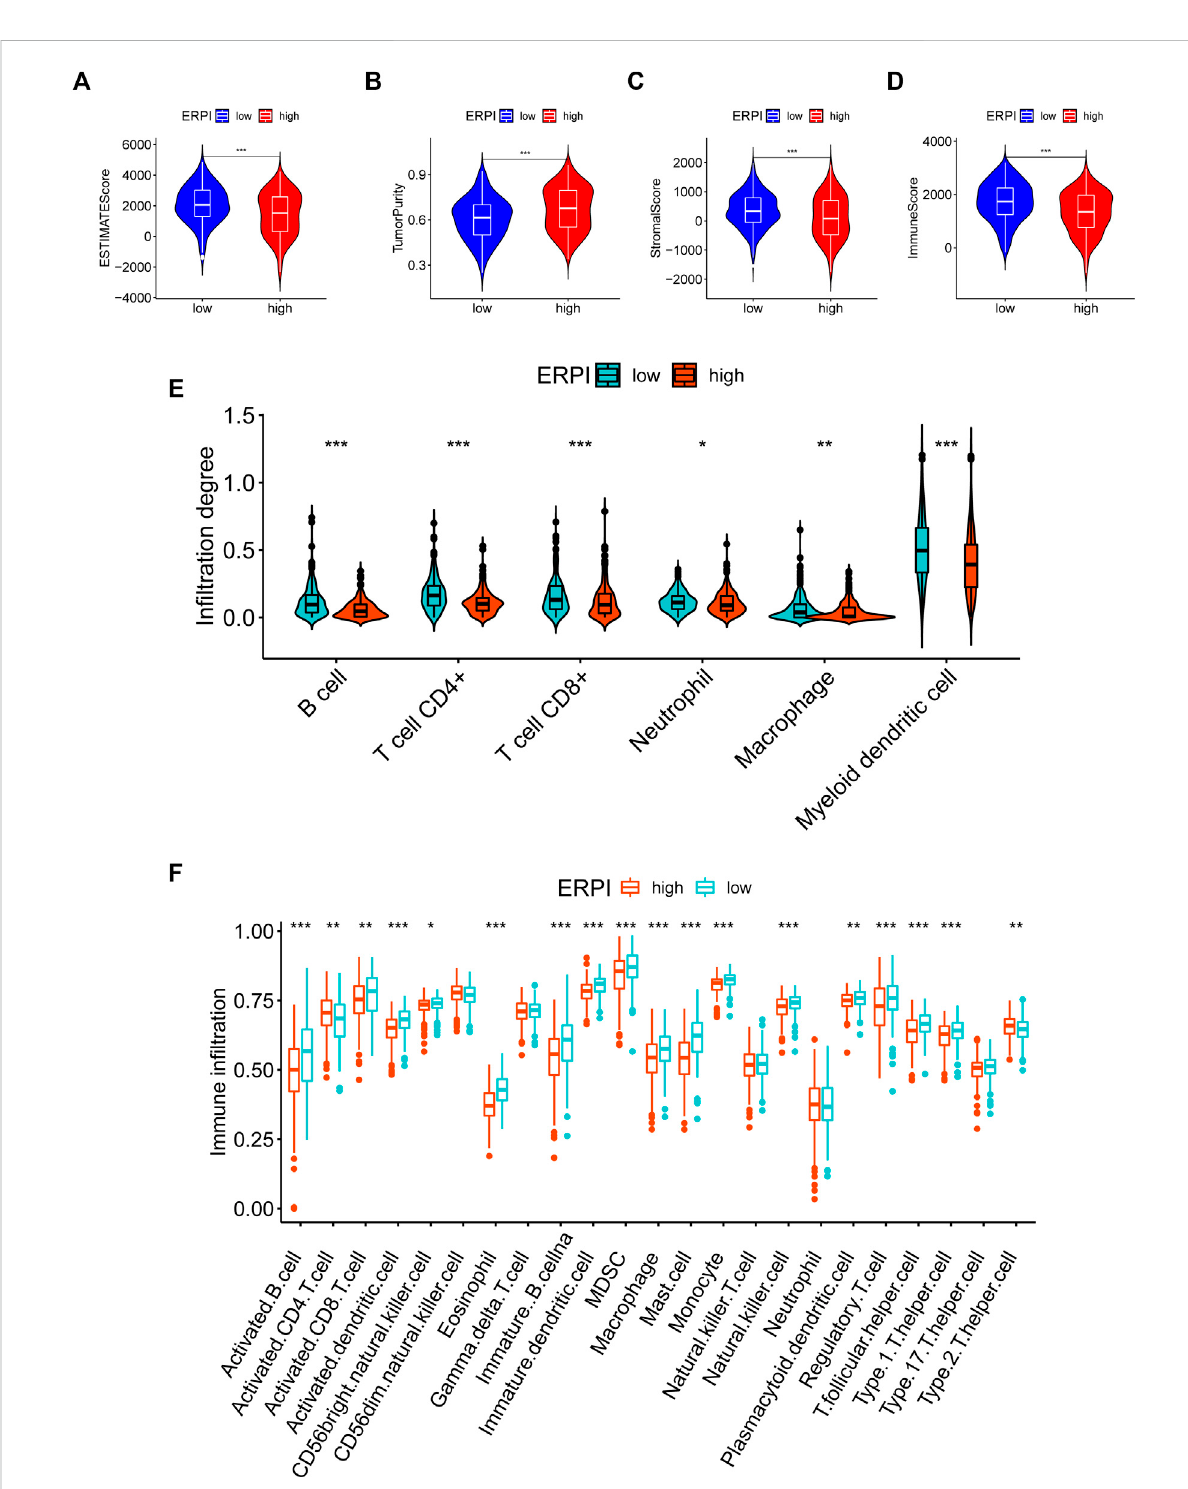
FIGURE 7 TME characteristics in the high- and low-ERPI groups. (A – D) ESTIMATE score, tumor purity, stromal score, and immune score between the high- and low-ERPI groups. (E) Abundance of immune cell subsets acquired via TIMER between the high- and low-ERPI groups. (F) Abundance of immune cell subsets acquired via ssGSEA between the high- and low-ERPI